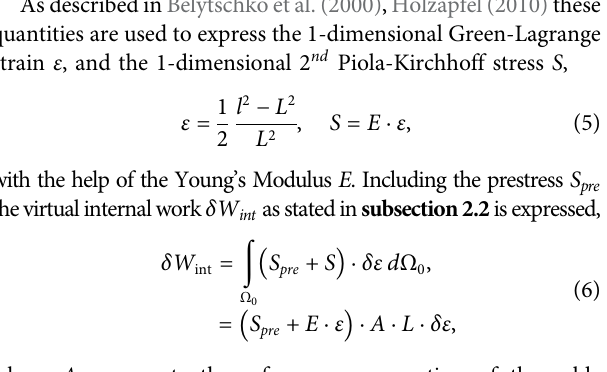
Frontiers in Built Environment |